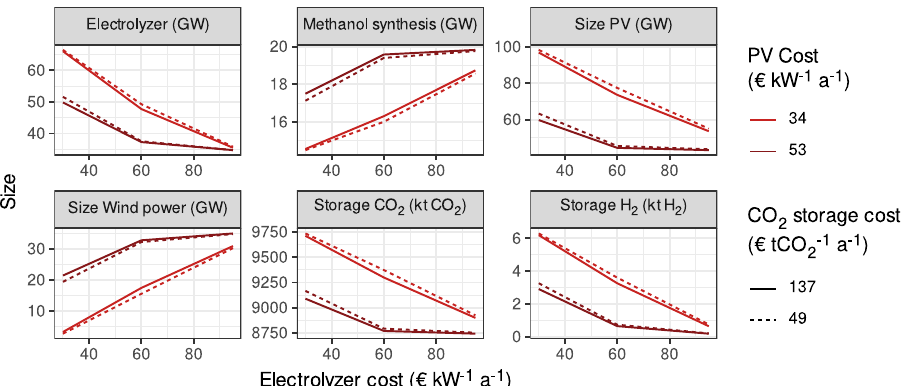
Fig. 4 Sizes of electrolyzers, methanol synthesis, solar PV, wind power, and storage installations. The fi gure shows the sum of all installed capacities at all locations in the solar – wind scenario. PV